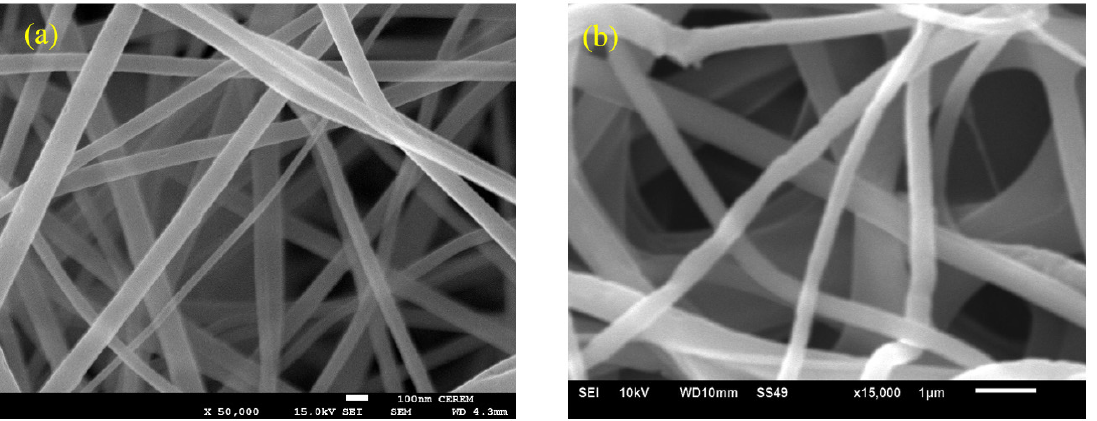
Figure 4. Titanium dioxide nanofibers ( a ) before calcination (reprinted with permission from [46]), and ( b ) after calcination.